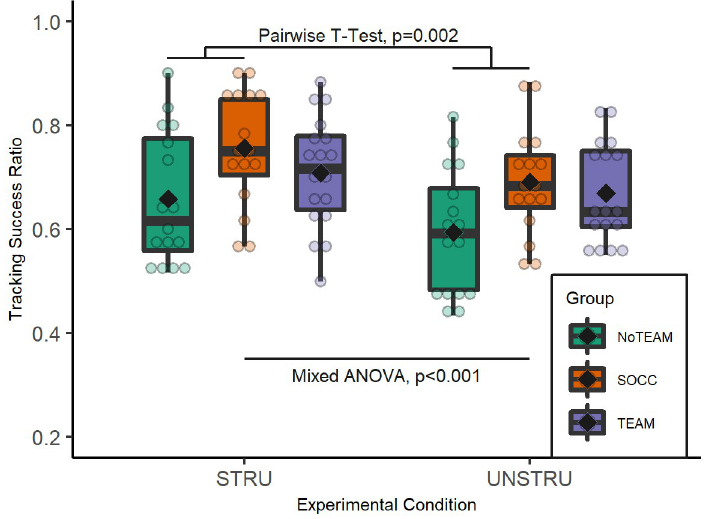
Fig 3. Tracking success ratio by group in both experimental conditions. Boxplots show distribution of subjects’ performance (fade dots) and ♦ represent group mean.